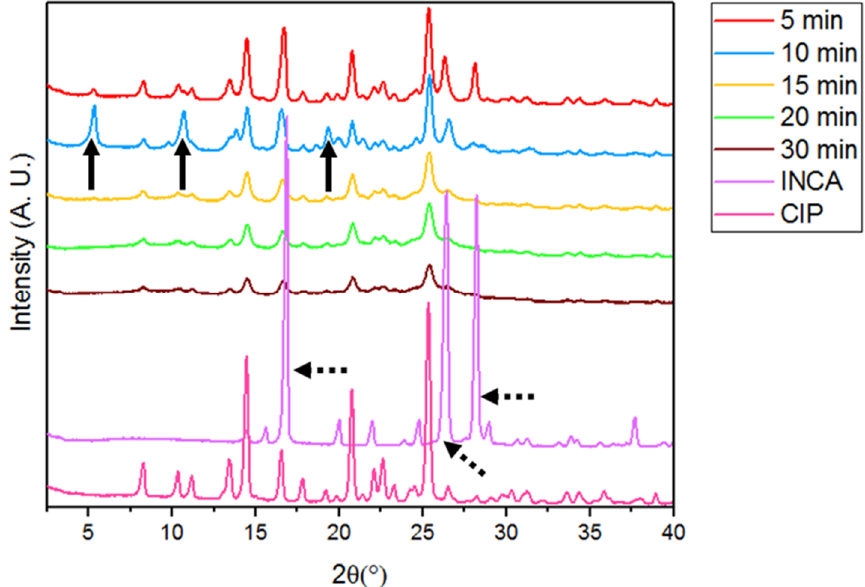
Figure 6. PXRD spectra of all ball milled samples for various duration of times.